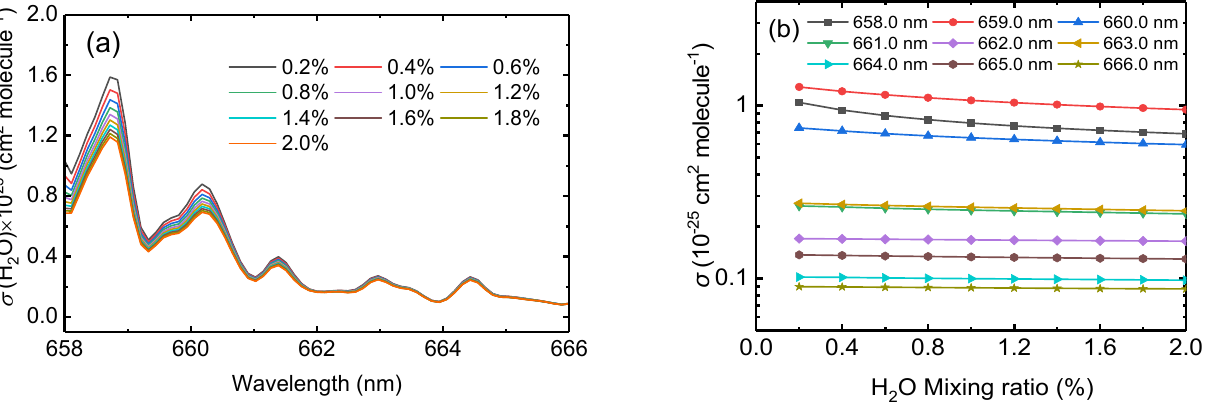
Figure 7. ( a ) The convolved H 2 O absorption cross section at ten different mixing ratios. ( b ) The change of the convolved H 2 O absorption cross section with the mixing ratios from 658 nm to 666 nm at 1 nm intervals. The y -axis uses a logarithmic scale here.